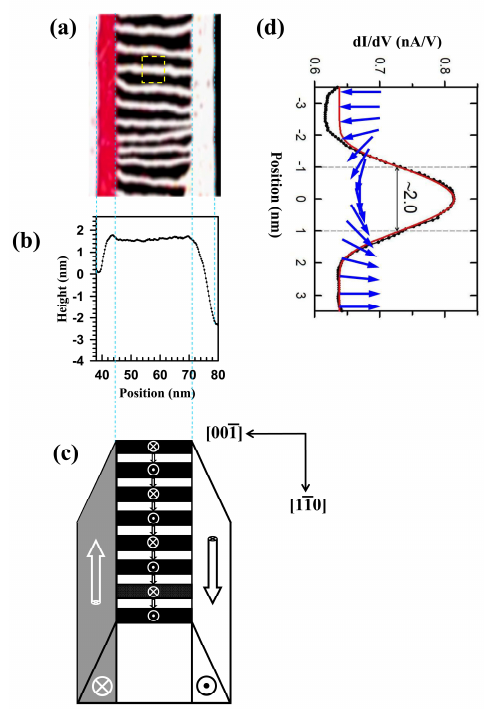
Figure 7. ( a ) The SP-d I / d V map and ( b ) the cross-sectional profile of the rectangular-sectional NW B. ( c ) Schematic sketch of the proposed magnetization configurations in the rectangular-sectional NW B. ( d ) The experimental SP-d I / d V profile across a domain wall (averaged over a yellow dashed box in ( a )), fitted by a 180° Néel wall.